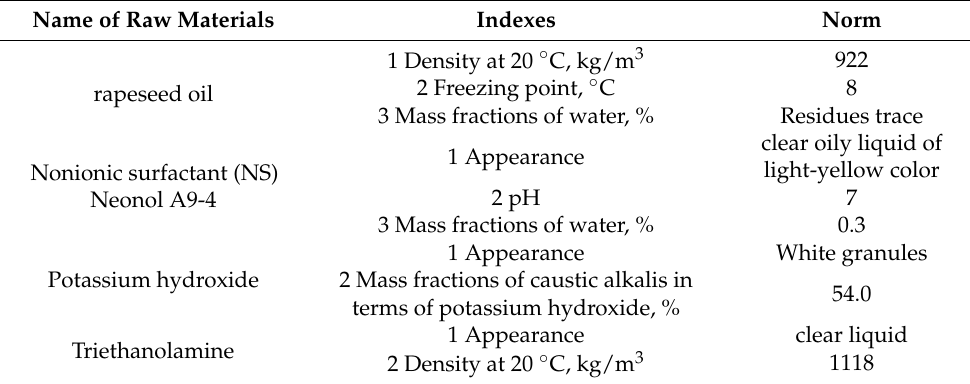
Table 4. Characteristics of raw materials for LCL.